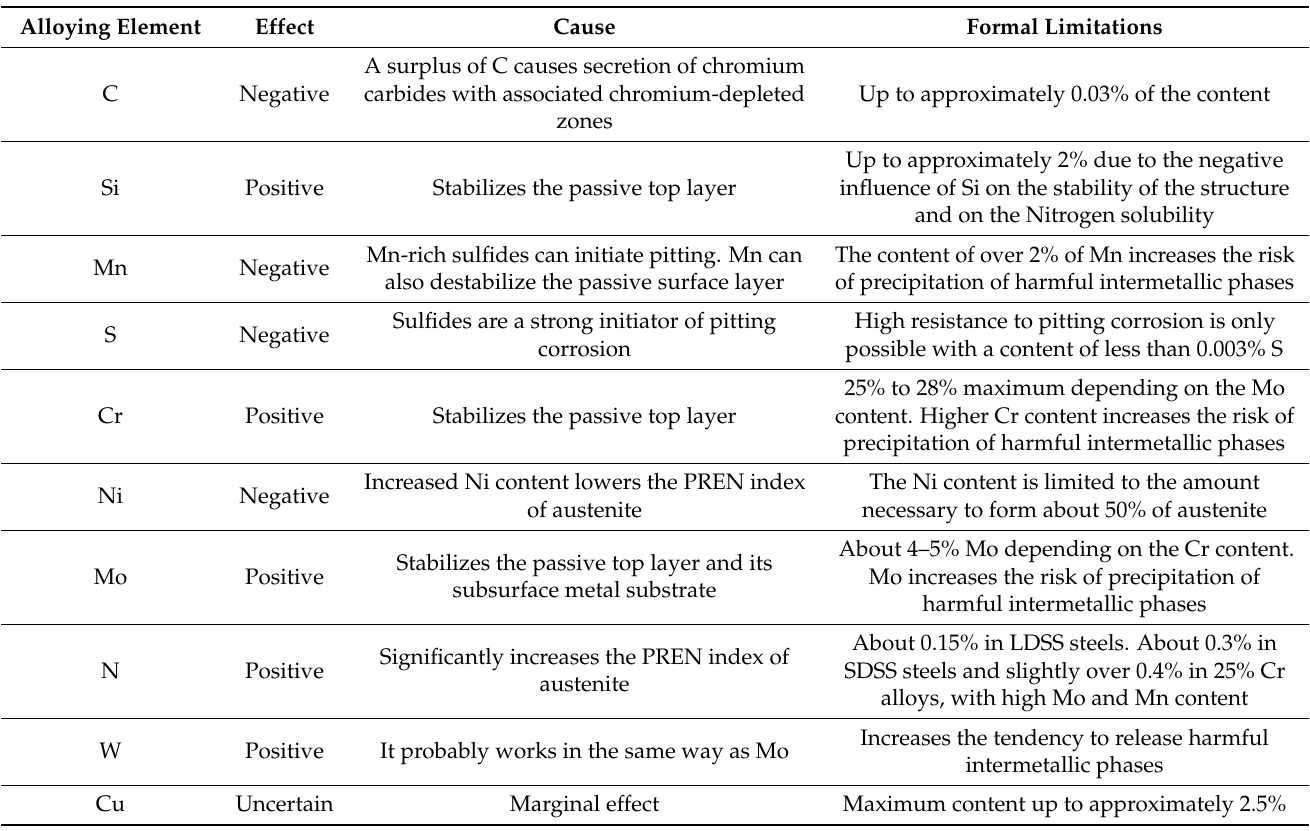
Figure 7. Schematic diagram of TTT (Time-Temperature-Transformation) specified for the typical duplex steels (according to [31]). Table 2. Influence of various alloy additions and steel microstructure on duplex steel pitting and slotted corrosion resistance (according to [32,33]).